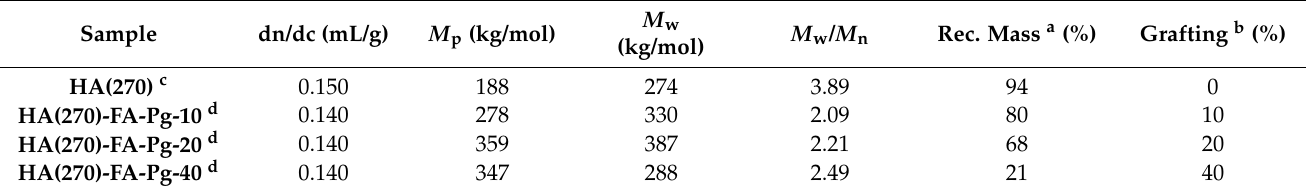
Table 2. Macromolecular features of HA(270)-FA-Pg graft copolymers compared to those of starting HA(270)